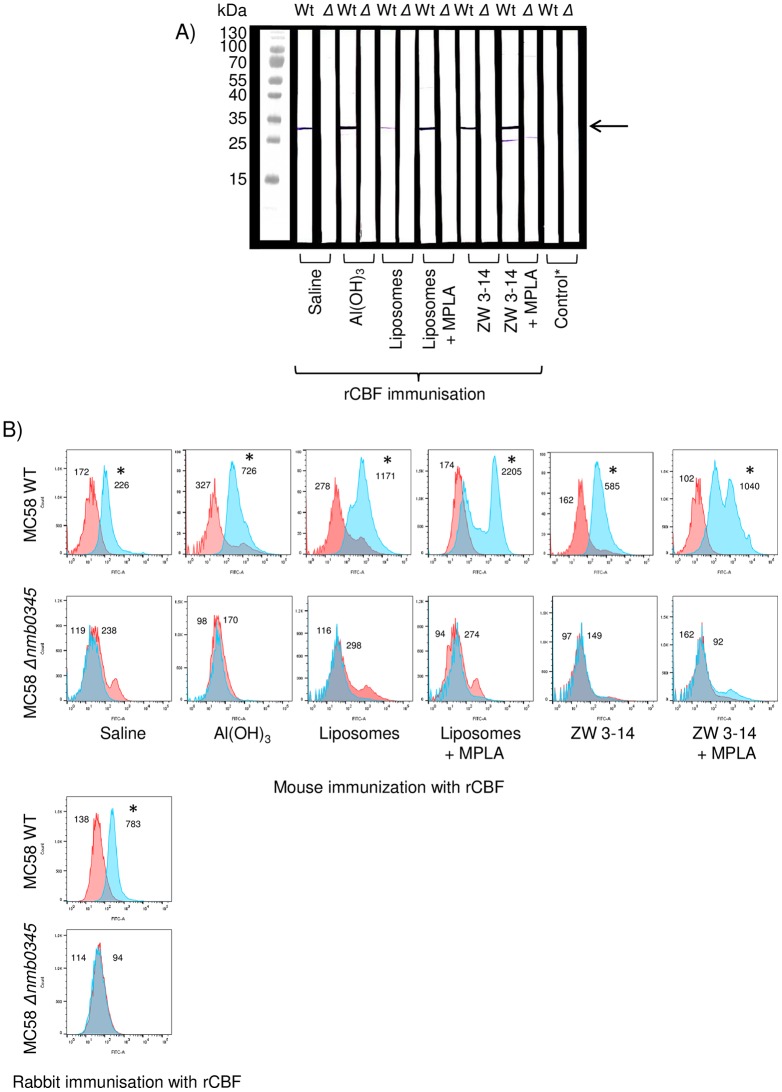
A) Specificity of murine anti-rCBF sera, examined by western immunoblot reactivity with CBF protein present in MC58 lysates. Pooled antisera (1/100 dilution) were reacted against wild-type MC58 lysate (Wt) and MC58 Δnmb0345 knock-out lysate (Δ) in western blot. CBF was recognised as a single protein band of Mr ~29.5 kDa (identified by the arrow) in wild-type MC58 (CBF+) but not in the knock-out strain (CBF-). All sham immunization sera and normal mouse serum were non-reactive against both Wt and knock-out strains, as demonstrated by representative strip blots (control*). B) CBF is expressed on the surface of MC58 meningococci as demonstrated by FACS analysis. On the top panel, the area within the red lines show no reactivity of wild-type MC58 (CBF+) bacteria with murine sham-immunised serum (1/10) and the area within the blue lines shows the significant FACS reactivity of murine antisera (1/10) raised against rCBF in the various formulations. The lower panel shows corresponding reactivity of the same murine sham-immunised sera and antisera against the MC58 Δnmb0345 (CBF-) knock-out strain. Rabbit post-immune serum (1/100) also reacted with the wild-type MC58 (CBF+) (area within the blue line), compared to pre-immune serum (area within the red lines) and no reactivity was observed with the MC58 Δnmb0345 (CBF-) knock-out strain. The numbers within each panel refer to the FITC-mean value. The * denotes the significant (p<0.05) and right-shifted increases in FITC-fluorescence recorded events, using a one sample t-Test to compare mean fluorescence values of test murine antisera against sham-immunised murine sera or rabbit post-immune antiserum against pre-immune serum. Data are representative of n = 2 experiments.